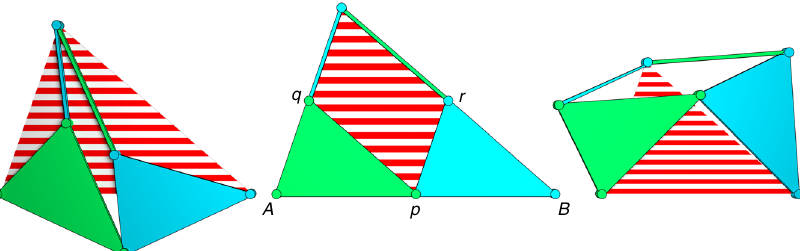
Fig. 3 The skew pantograph. The skew pantograph is a one-degree-of-freedom mechanism that scales the spanned triangle (i.e., the red-striped area) determined by three of its joints; the similarity points, indicated A ; B , and C . This mechanism has revolute joints at points p ; q ; C ; and r . For the neutral position, shown in the middle, the spanned triangle equals the triangular shape of the pantograph, this is a useful pose for constructing dilational surfaces